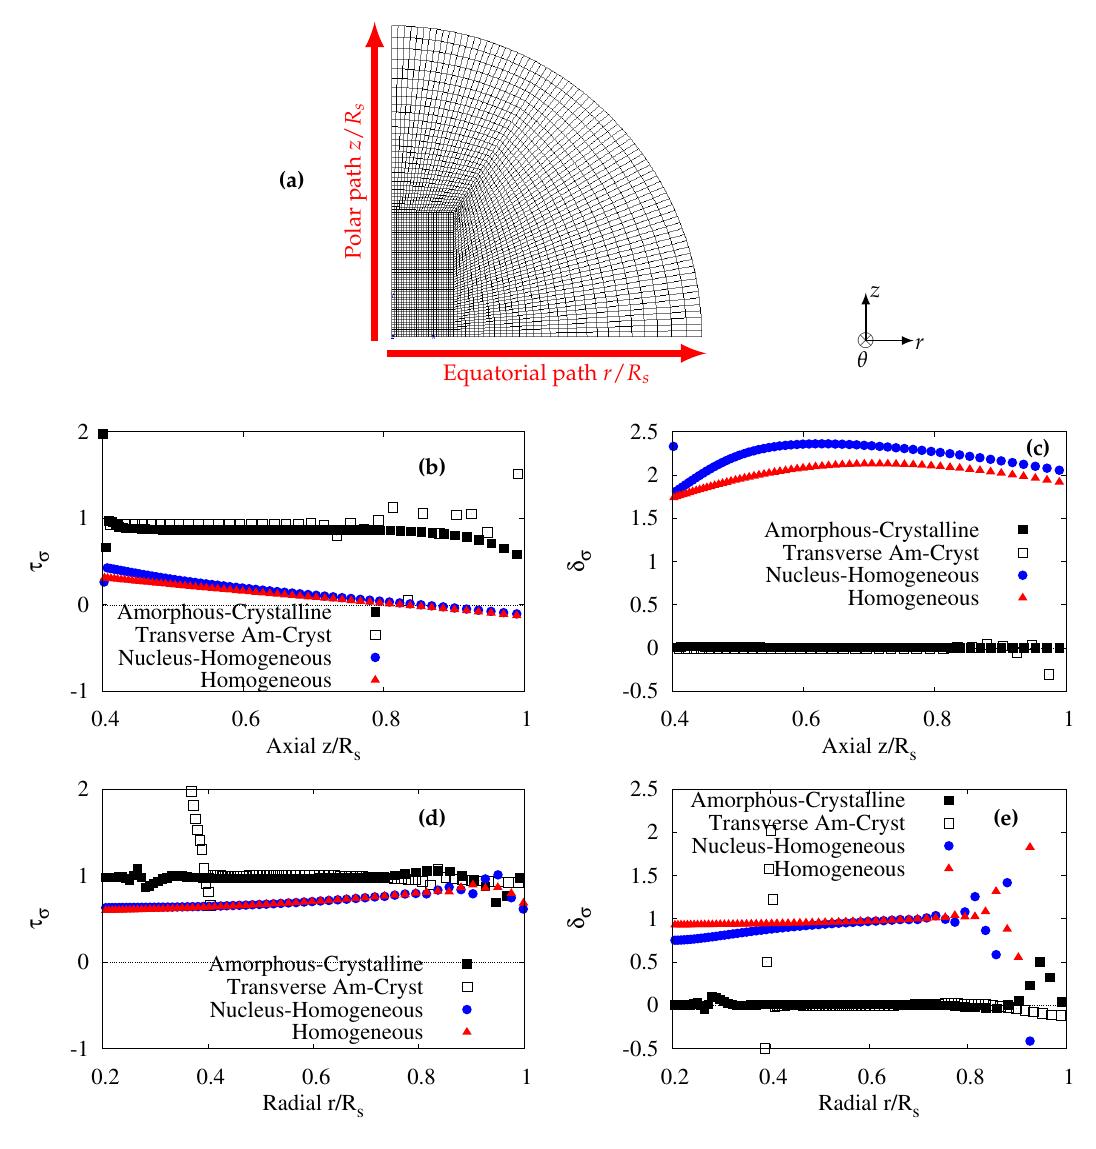
Figure 6. Spherulite under uniaxial tensile stress: ( a ) mesh and coordinates; ( b ) stress triaxiality ratio τ σ along the axial path; ( c ) δ σ parameter along the axial path; ( d ) stress triaxiality ratio τ σ along the radial path; ( e ) δ σ parameter along the radial